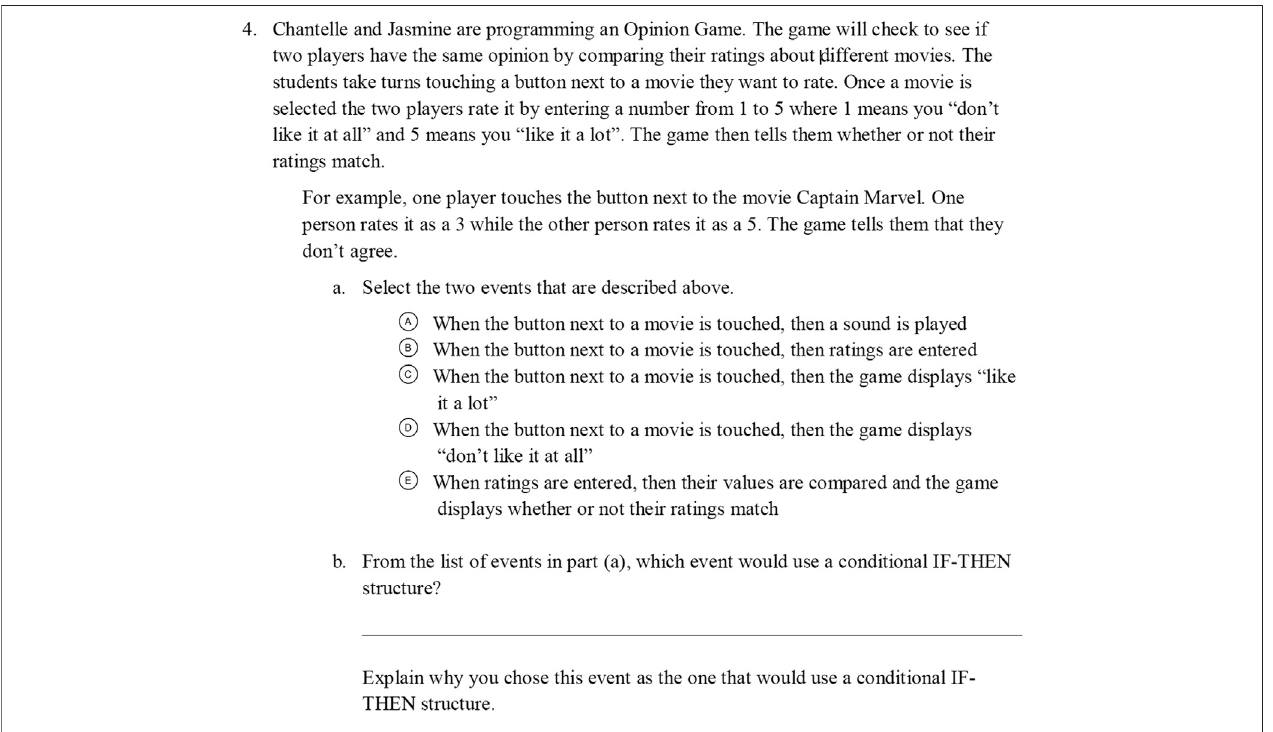
FIGURE 5 | Sample item: Unit 4 assessment, item 4.